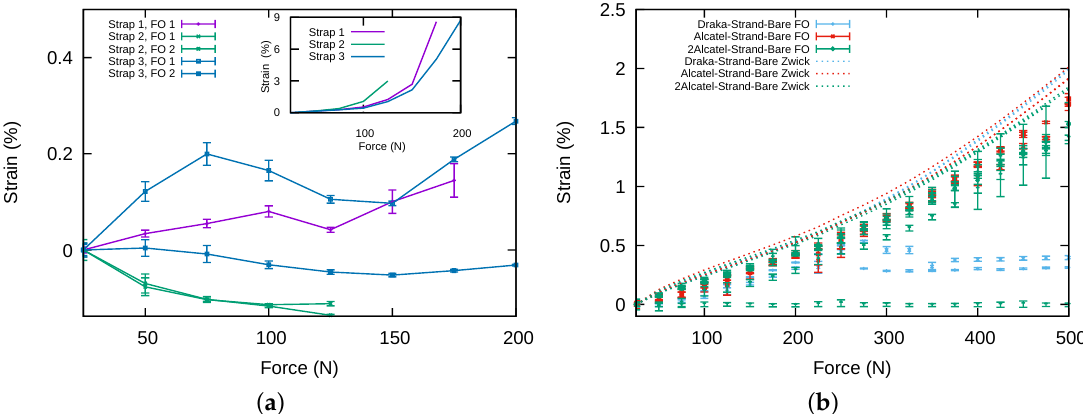
Figure 14. ( a ) Strain measured by the tensile testing machine and the optical fibres when the polymer film only is bonded to clamping parts. ( b ) Strain measured by the optical fibre when the polymer film, the optical fibres and the strands are bonded to clamping parts (FO denotes strain measured by optical fibres and Zwick strain measured by testing